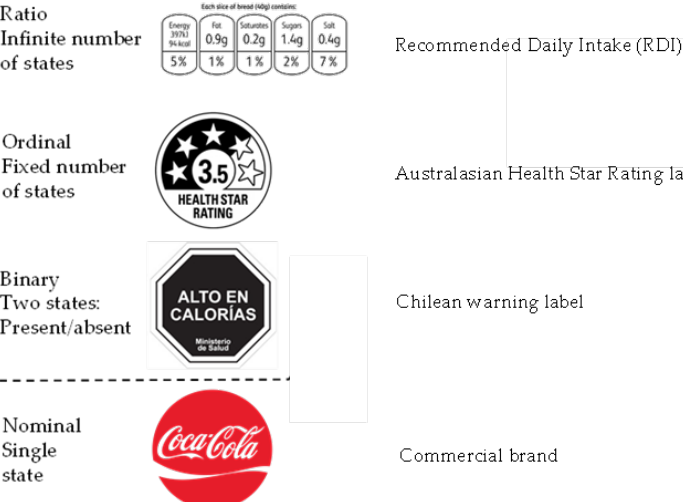
Figure 1. A classification of cues that are encountered on food products at the point of sale. Front of pack (FoP) labels display a wide variety of formats, but only represent a small proportion of the total cues encountered. The vast majority of package cues are nominal and proprietary commercial brand related logos and images, but also include non-proprietary health claims etc. A nominal cue is a recognizable ‘shape’, which may be a word, a design or a combination of the two that has a specific non-dimensional meaning to its target, e.g., the Coca-Cola ® brand). Some widely deployed generic (ownerless) cues, e.g., ‘lite’/’organic’, may display both binary and nominal characteristics. Binary FoP labels are the closest approach to the nominal cue format that forms the basis of commercial food branding and marketing communication practice [24]. However, it should be noted that using multiple warning labels destroys this binary status, and introduces a level of complexity that increases exponentially with the number of labels used. The four octagon Chilean system for example has 16 possible combinations arranged in five broad statuses with zero to four octagons. However, as each ‘state’ comprises multiple combinations of octagons of indeterminate relative value, the system cannot be described as ordinal (Figure 2). The regulatory uptake of FoP warning labels has been swift and decisive. In addition to Chile, compulsory FoP systems based on this approach were introduced in Peru in 2018 [25,26], and they are approved for introduction in Israel in 2020 [27,28] and are under active development in Canada, Mexico and Uruguay [9,29 – 31]. The sharp move towards compulsion is noteworthy, and is in contrast to the established FoP formats, which remain voluntary in the areas where they have been deployed, even when these labels have been deployed in those areas for a long period of time. The rapid move to deploy compulsory FoP systems based upon warning labels may be premature given the still rapidly developing body of research evidence that is currently available to decision makers [10]. This lack of evidence not only applies to the efficiency of the warning label